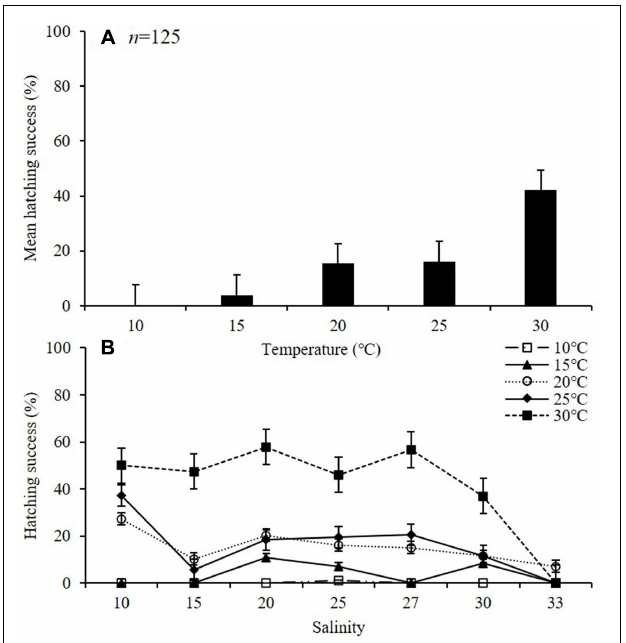
FIGURE 3 | Hatching success (HS) of eggs of adult female Acartia ohtsukai . Mean HS at each temperature (A) and HS at each temperature and salinity (B) are shown. Data are presented as mean ± standard error (SE). Different letters above the bars indicate significant differences ( p < 0.05).